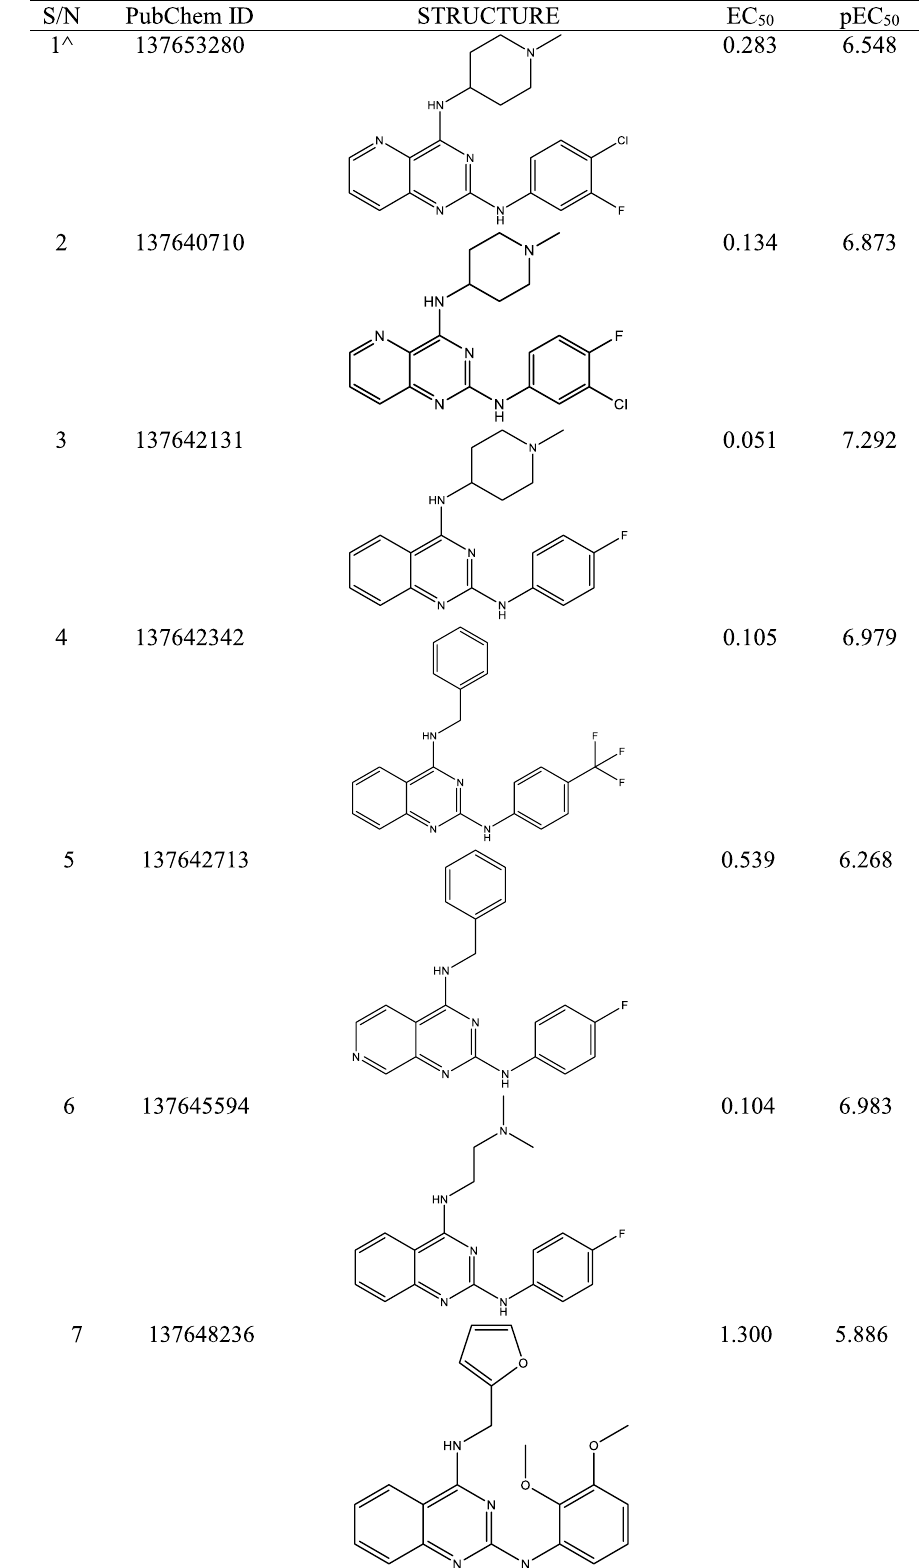
Table 1 Molecular structures of 2-Anilino 4-Amino Substituted Quinazolines derivatives, their PubChem ID, along side their activities against P. falciparum